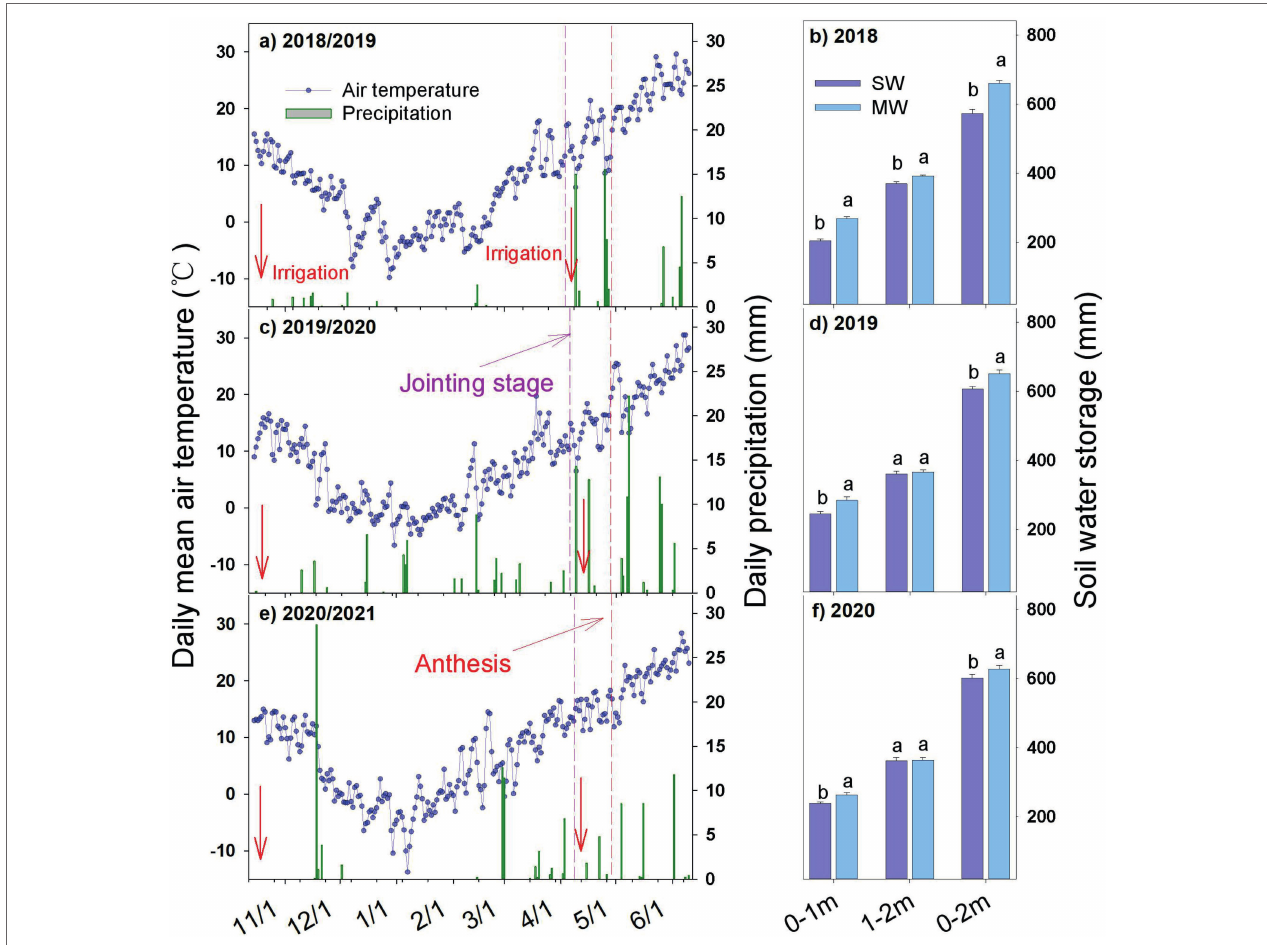
FIGURE 1 | Weather condition (A,C,E) during winter wheat growing seasons and soil water storage (B,D,F) before winter wheat sowing in summer maize − winter wheat (MW) and summer soybean − winter wheat (SW) rotation systems. Values are means + SEs ( n = 3) for soil water storage. Different lowercase letters indicate significant differences ( p <